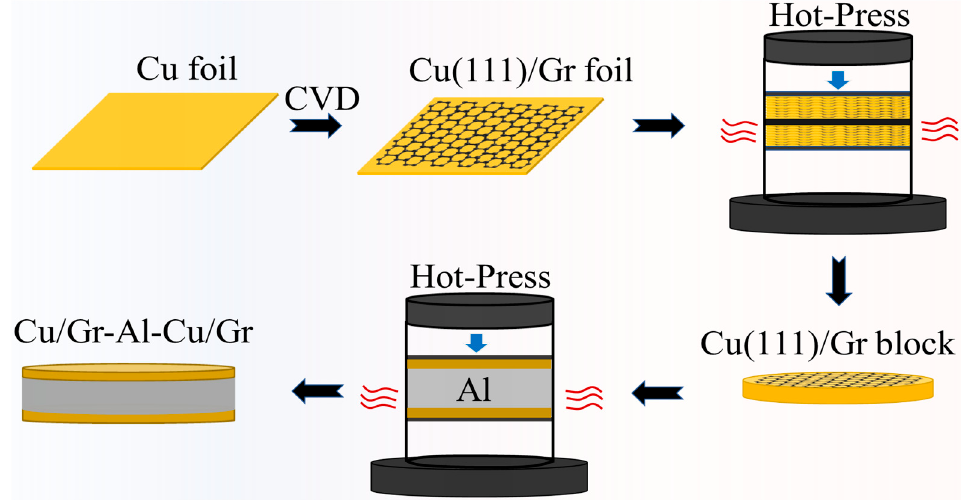
Figure 1. Schematic diagram of the Cu/Gr-Al-Cu/Gr preparation